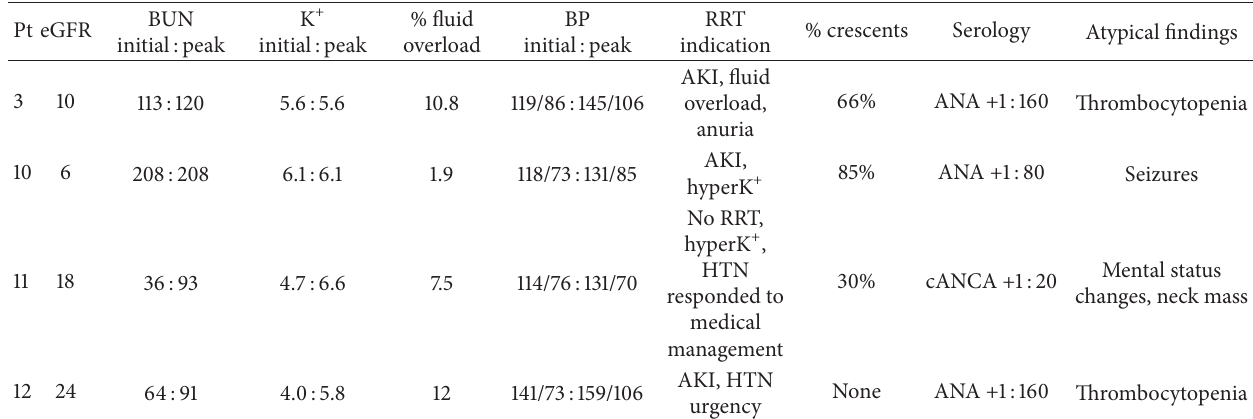
Table 4: Patients with atypical